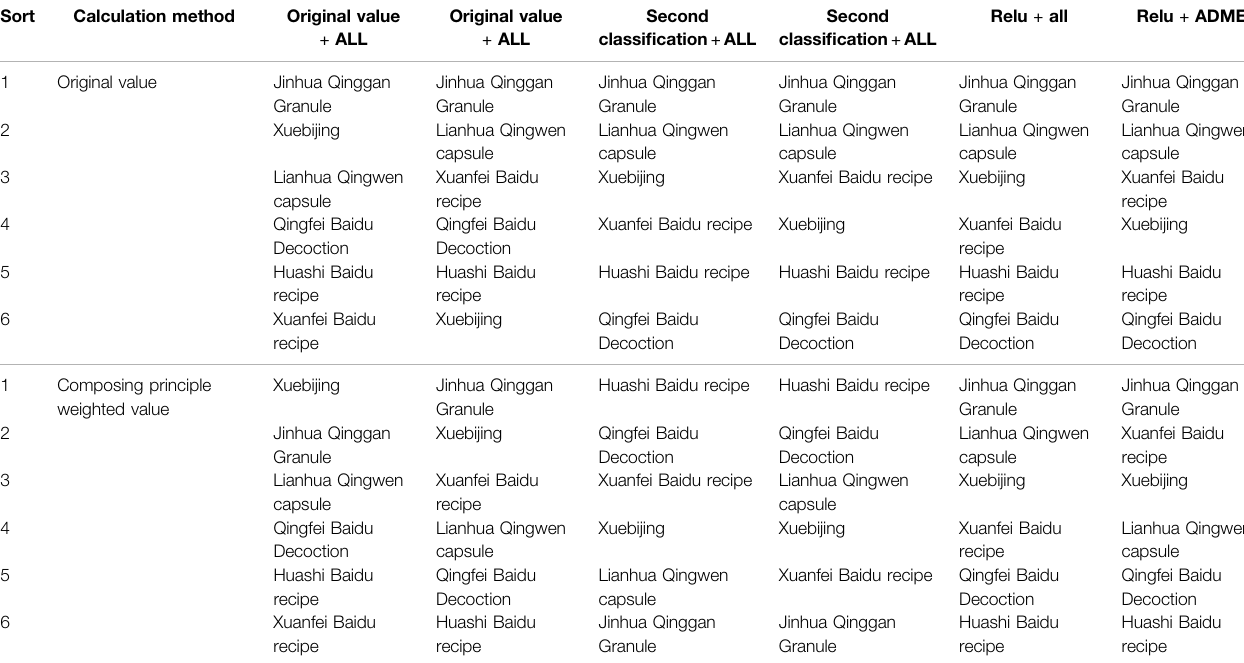
TABLE 4 | Ranking of docking results of three TCM prescriptions and three medicines.